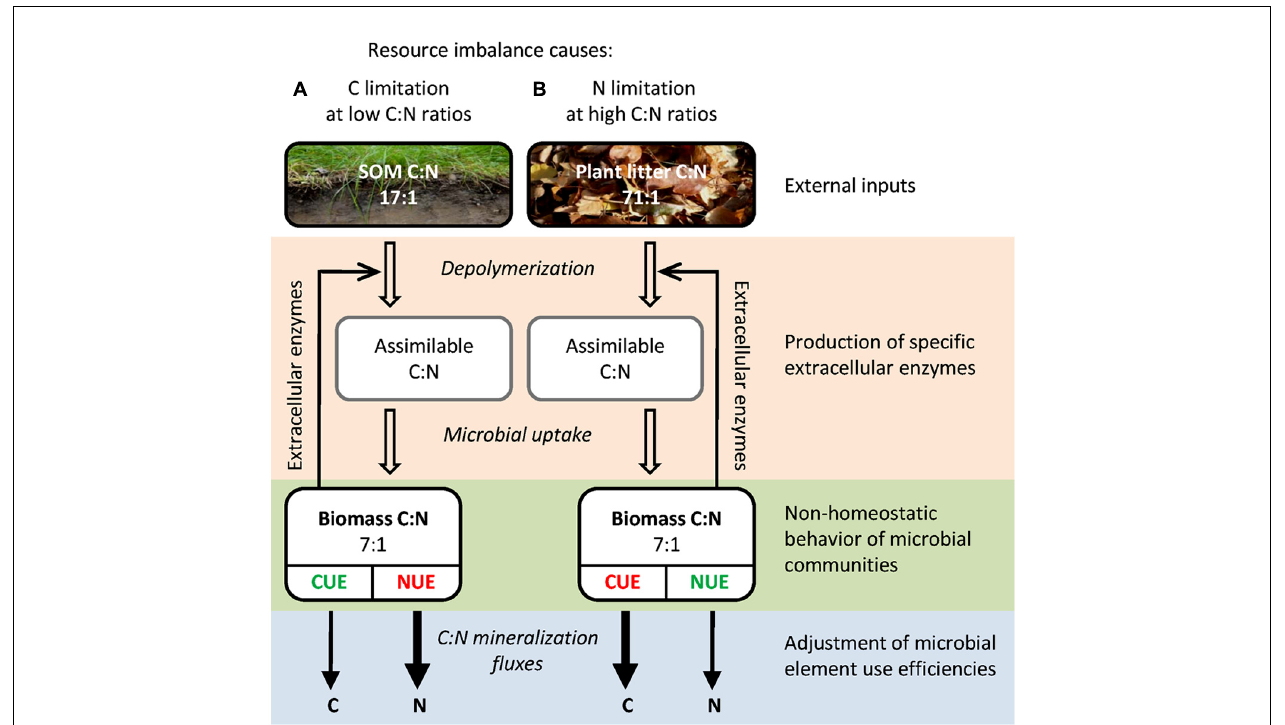
adjustment in the production of extracellular enzymes as C and nutrient acquisition strategy, non-homeostatic behavior of microbial communities and adjustment of microbial element use efficiencies. Given are global average molar C:N ratios (Yuan and Chen, 2009; Xu etal., 2013). The scheme is also applicable for P, by substitution of C:N ratios by C:P (plant litter, 3,055:1; SOM, 287:1; microbial biomass, 42:1; Table 1 ) as well as NUE by phosphorus use efficiency (PUE). Abbreviations: SOM, soil organic matter; CUE, carbon use efficiency; NUE, nitrogen use